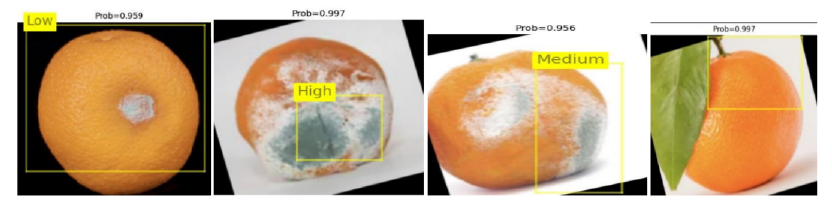
Figure 9. Result showing four levels of severity in image